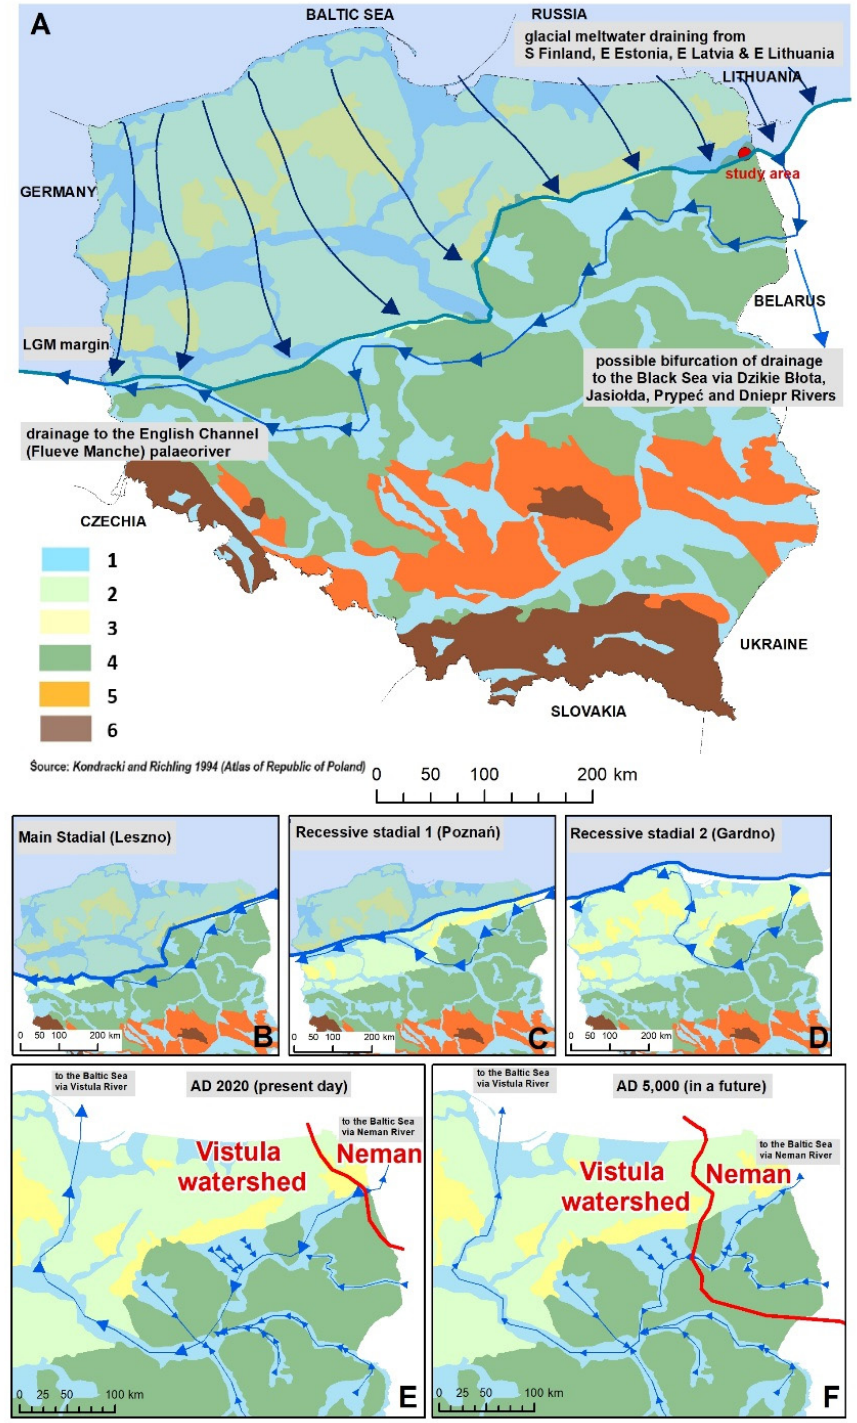
Figure 2. Evolution of hydrological system in Southeast sector of Baltic Sea basin during ( A ) LGM (possibly asynchronous in Poland, referenced to ´Swiecie stadial in the study area [16,19]; ( B ) main (Leszno) stadial; ( C ) recessive (Pozna´n) stadial; ( D ) recessive (Gardno) stadial; ( E ) present day; ( F ) in the future. Description of colors—types of landscape [20]: 1—large river valleys, ice marginal valleys, wide tectonic or melt-out depressions; 2—lakeland, glacial (young) high plains in the LGM extent; 3—sandurs and outwash plains in the LGM extent; 4—old glacial (Saalian and older) high plains beyond the LGM extent; 5—upland; 6—mountains (Carpathians, Sudetes, Holly Cross Mountains) and their